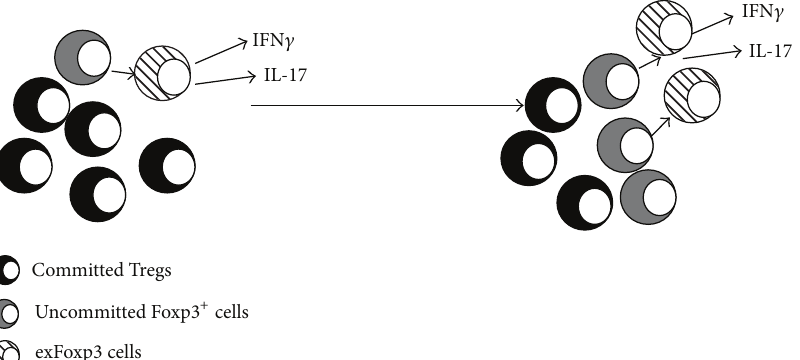
Figure 2: Natural Tregs represent a stable cell lineage; however, there is a minor fraction of Foxp3 + T cells that lack Foxp3 expression, which of conversion to exFoxp3 cells is accelerated under lymphopenic or inflammatory